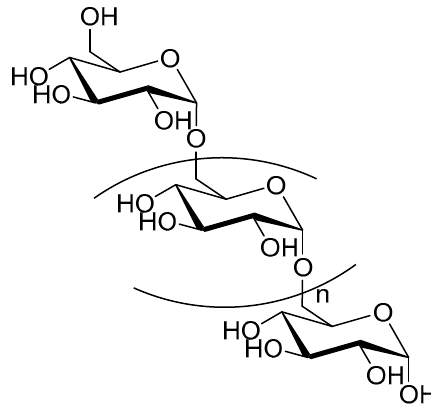
Figure 1. Chemical structure of main component of dextrans ( α -(1 → 6) linkages).